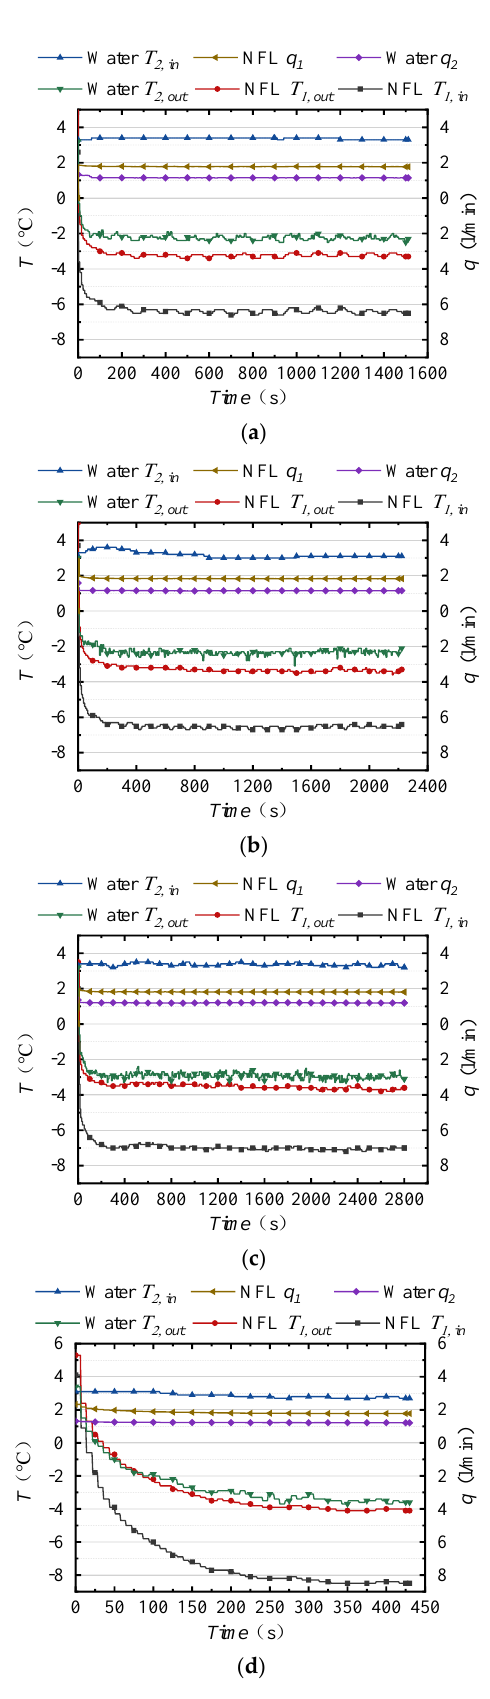
Figure 3. Experimental results. ( a ) −2.1 °C subcooled water. ( b ) −2.4 °C subcooled water. ( c ) −3 °C subcooled water. ( d ) −3.6 °C subcooled water.